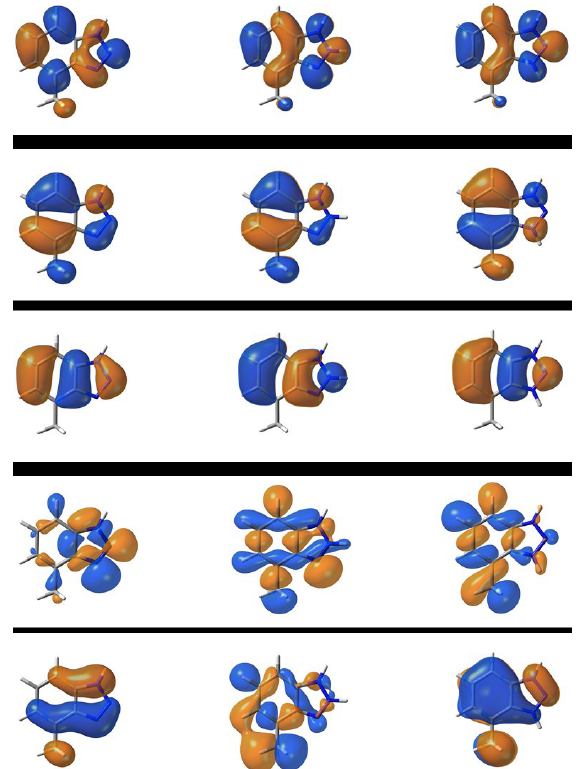
Figure 16. Molecular Orbitals of (a) TTA-4, (b) HTTA + and (c) HTTA +